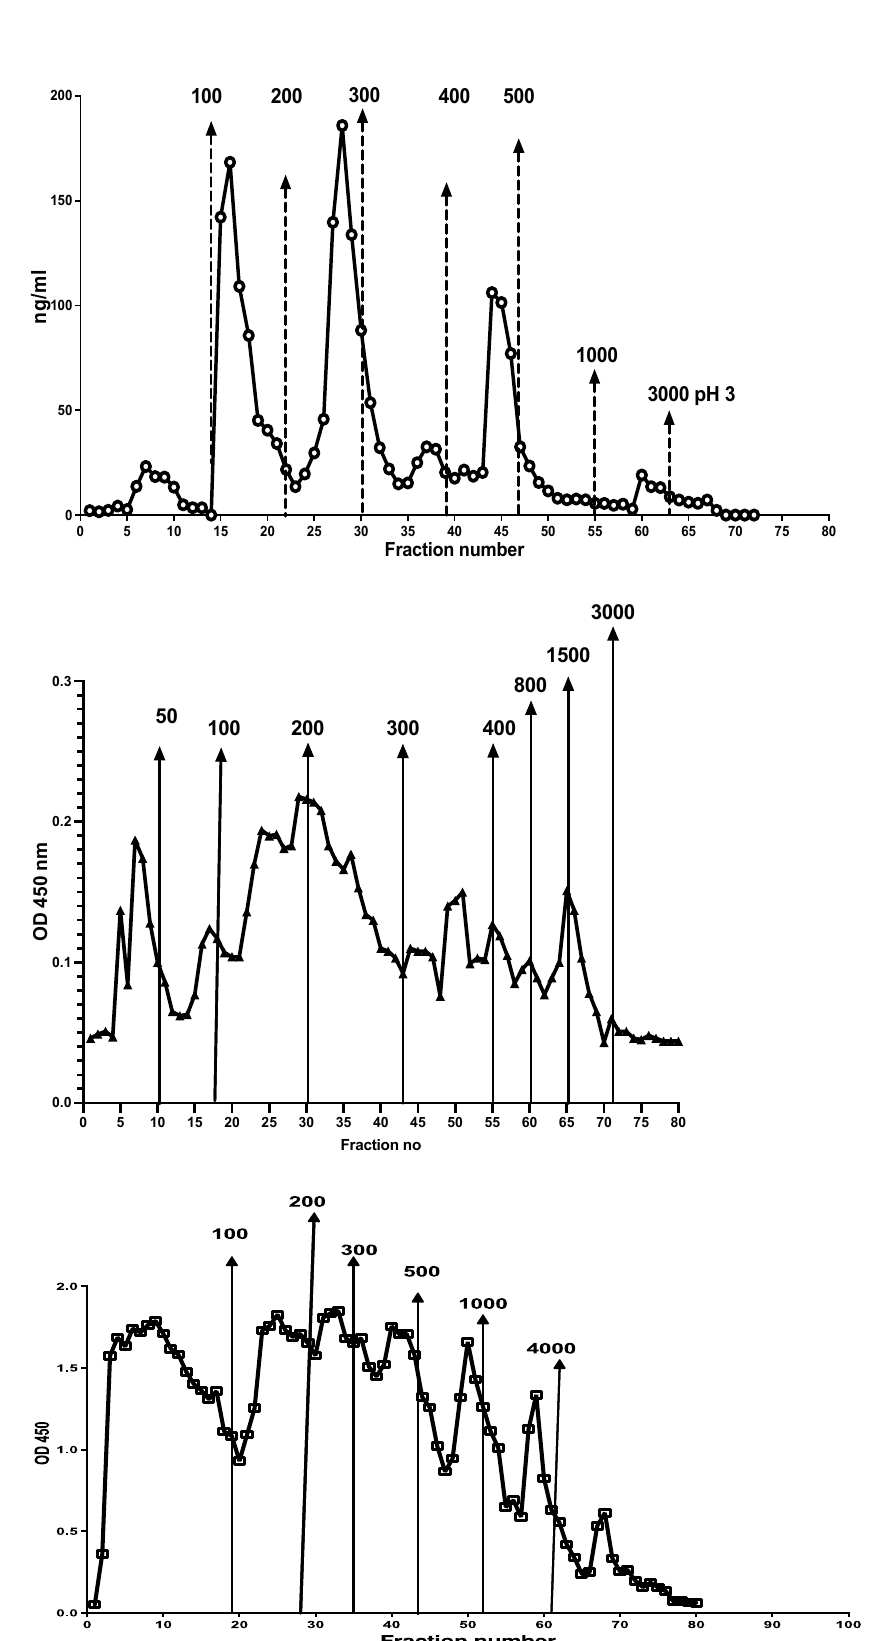
Figure 7. Stool extracts from different patients gave many different CP containing chromatographic patterns, perhaps reflecting degradation of NETs exposed to different concentrations of DNases or microbial endonucleases. Possible relation to diagnosis and disease activity remains to be studied.